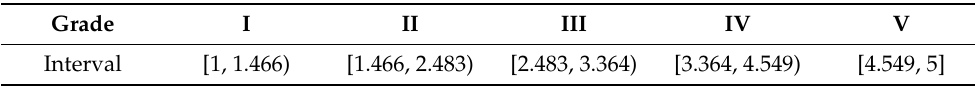
Table 3. CMDRI grade simulation interval of RF model.